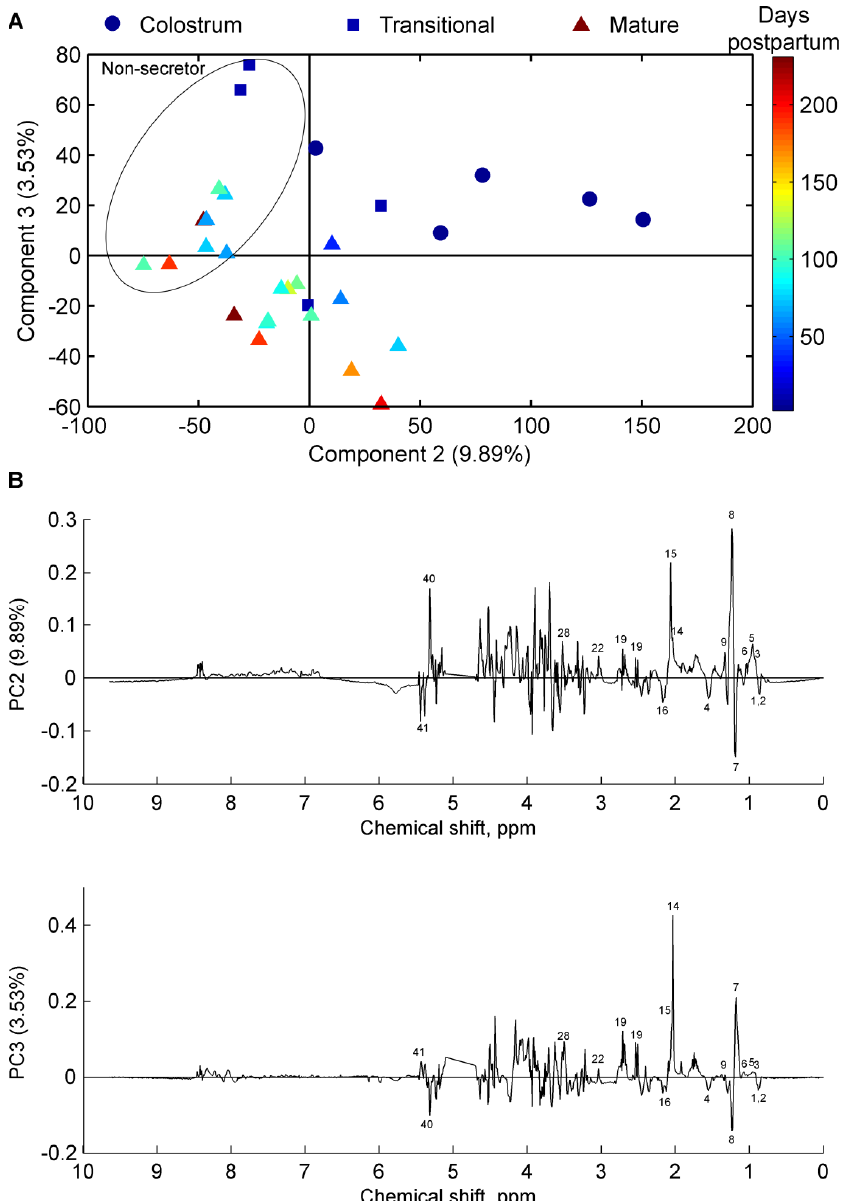
Figure 2. ( A ) Principal component analysis scores plot of full-term milk samples from 30 mothers ( n = 30)); samples are coloured according to days postpartum; Colostrum (dots), transitional (squares), and mature (triangles); the circle denotes samples from non-secretor mothers, while remaining samples are from secretor mothers; and ( B ) corresponding loading line plots. For peak assignments refer to Table 3.